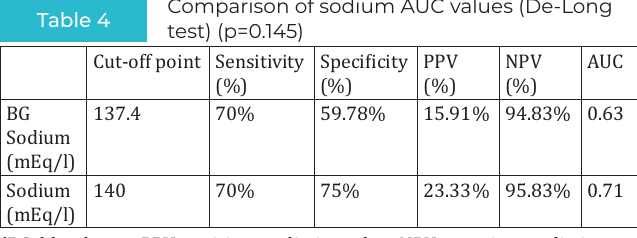
Cut-off point Sensitivity